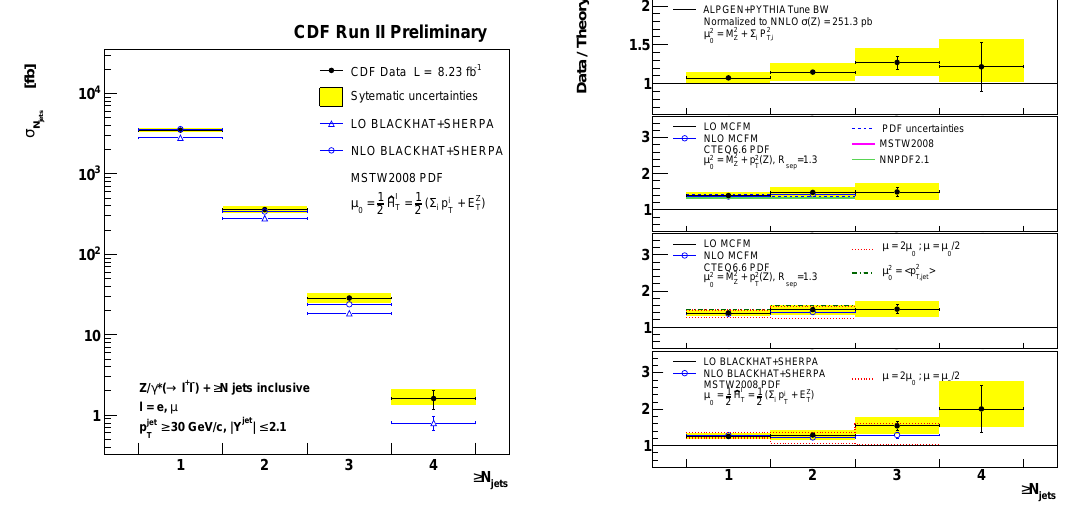
4. Comparison is made to LO / NLO pQCD −